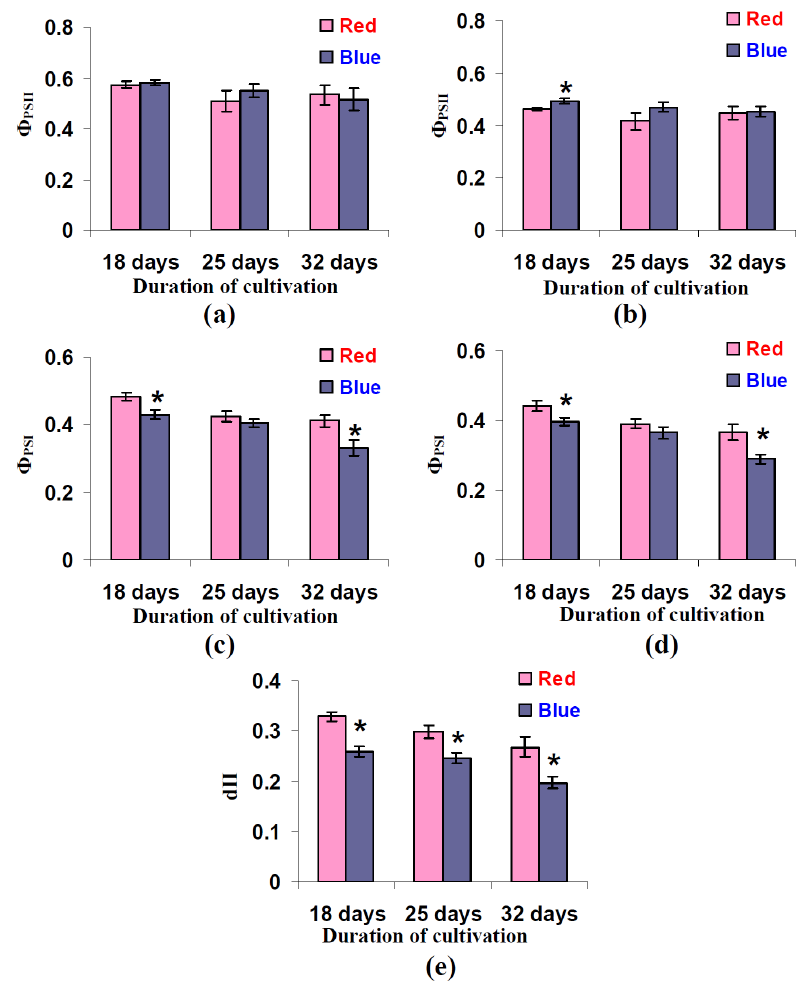
Figure 8. Influence of the red (marked as “Red”) and blue (marked as “Blue”) illumination variant during lettuce cultivation on the quantum yield of photosystem II (Φ PSII ) at the 978 µmol m −2 s −1 intensity of RL ( a ), Φ PSII at the 758 µmol m −2 s −1 intensity of BL ( b ), the quantum yield of photosystem I (Φ PSI ) at the 978 µmol m −2 s −1 intensity of RL ( c ), Φ PSI at the 758 µmol m −2 s −1 intensity of BL ( d ), and the fraction of the absorbed light distributed to photosystem II (dII) ( e ) ( n = 5–7). Illumination spectra are shown in Figure 1. * differences between plants cultivated at the red and blue variants of illumination are significant ( p < 0.05).